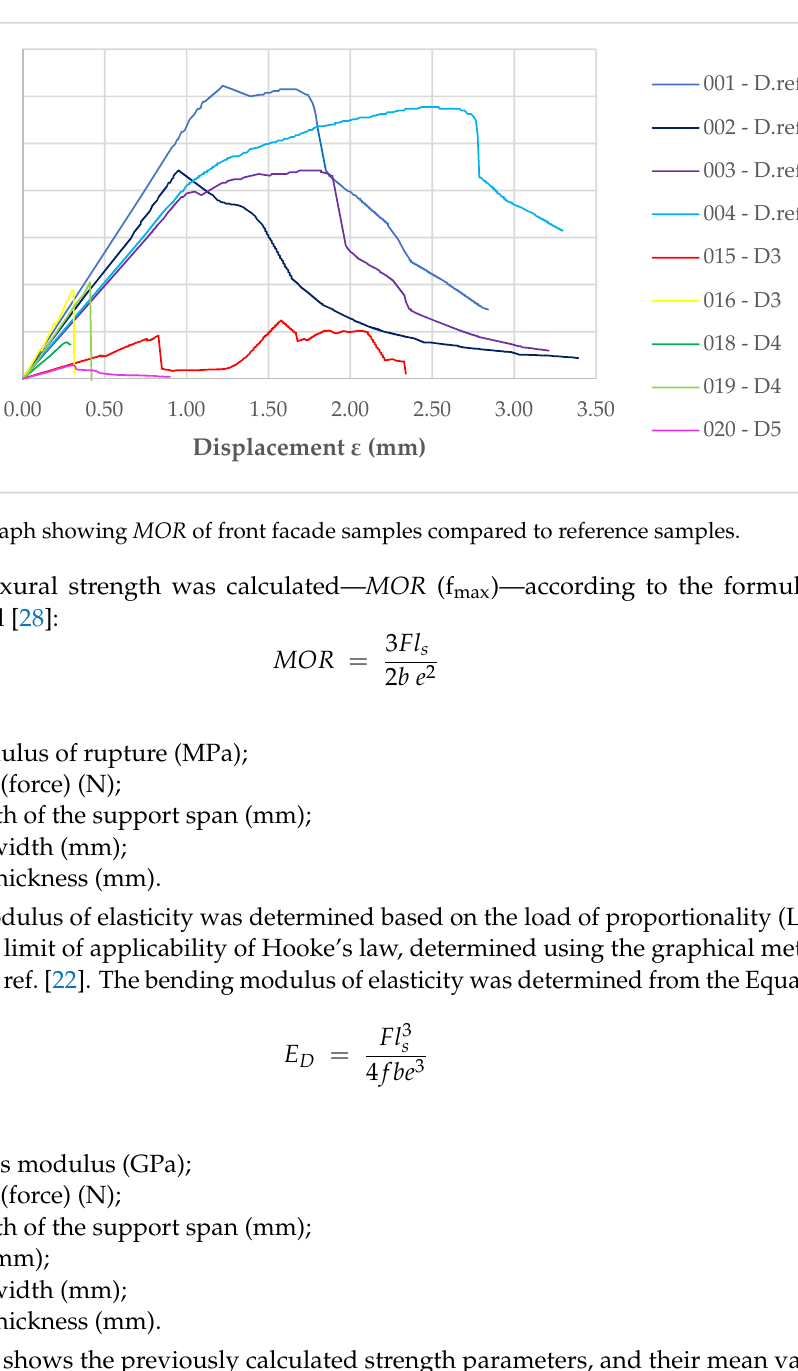
Figure 11. Graph showing the modulus of rupture ( MOR ) of the reference samples.